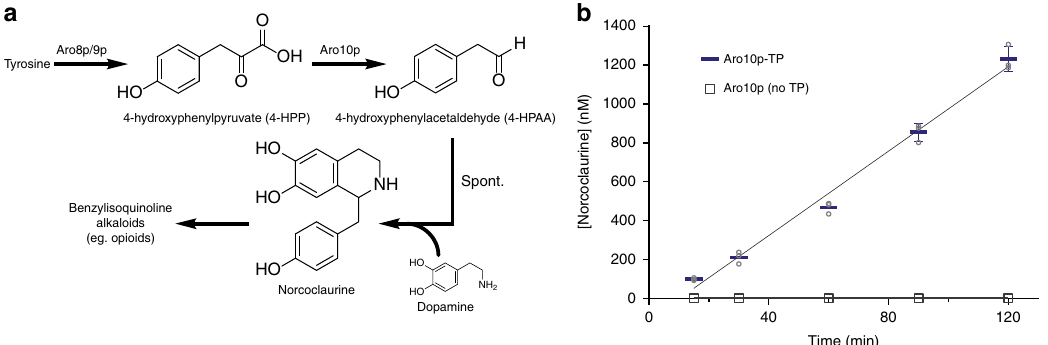
Fig. 4 Enzymatic catalysis inside encapsulin compartments. a The Aro10p enzyme is involved in tyrosine catabolism, generating 4- hydroxyphenylacetaldehyde (4-HPAA) which can be measured by QTOF-LCMS after conversion to norcoclaurine by spontaneous reaction with dopamine. This pathway has previously been used to engineer the production of opioids in yeast 29 . b Puri fi ed encapsulin nanocompartments show enzymatic activity only when co-expressed with the version of Aro10p that is fused with the targeting peptide (TP). Encapsulins were puri fi ed from yeast strains co- expressing the encapsulin and either Aro10p-TP or non-targeted Aro10p (see Supplementary Methods and Supplementary Table 1 for strain construction). Error bars represent the standard deviation of three technical percentage of 42% for Ven-N and 30% for Ven-C (~76 and 54 per compartment, respectively) based on SDS-PAGE analysis (Fig. 3f).